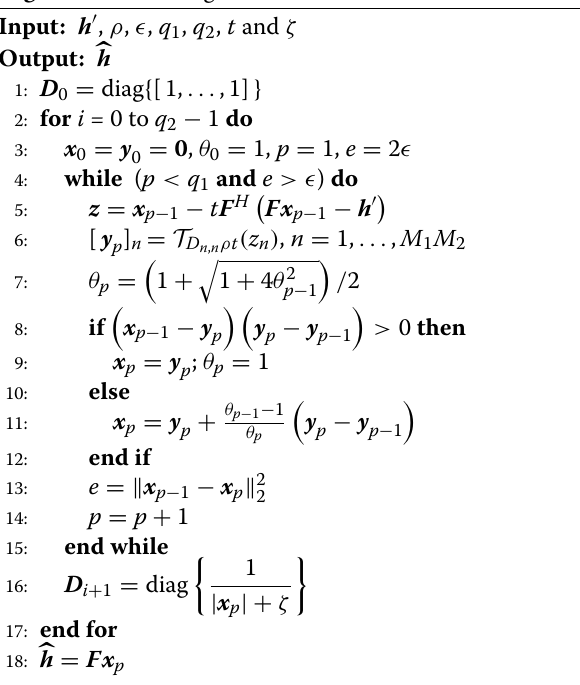
Algorithm 2 AGDAR algorithm Algorithm 3 RCS